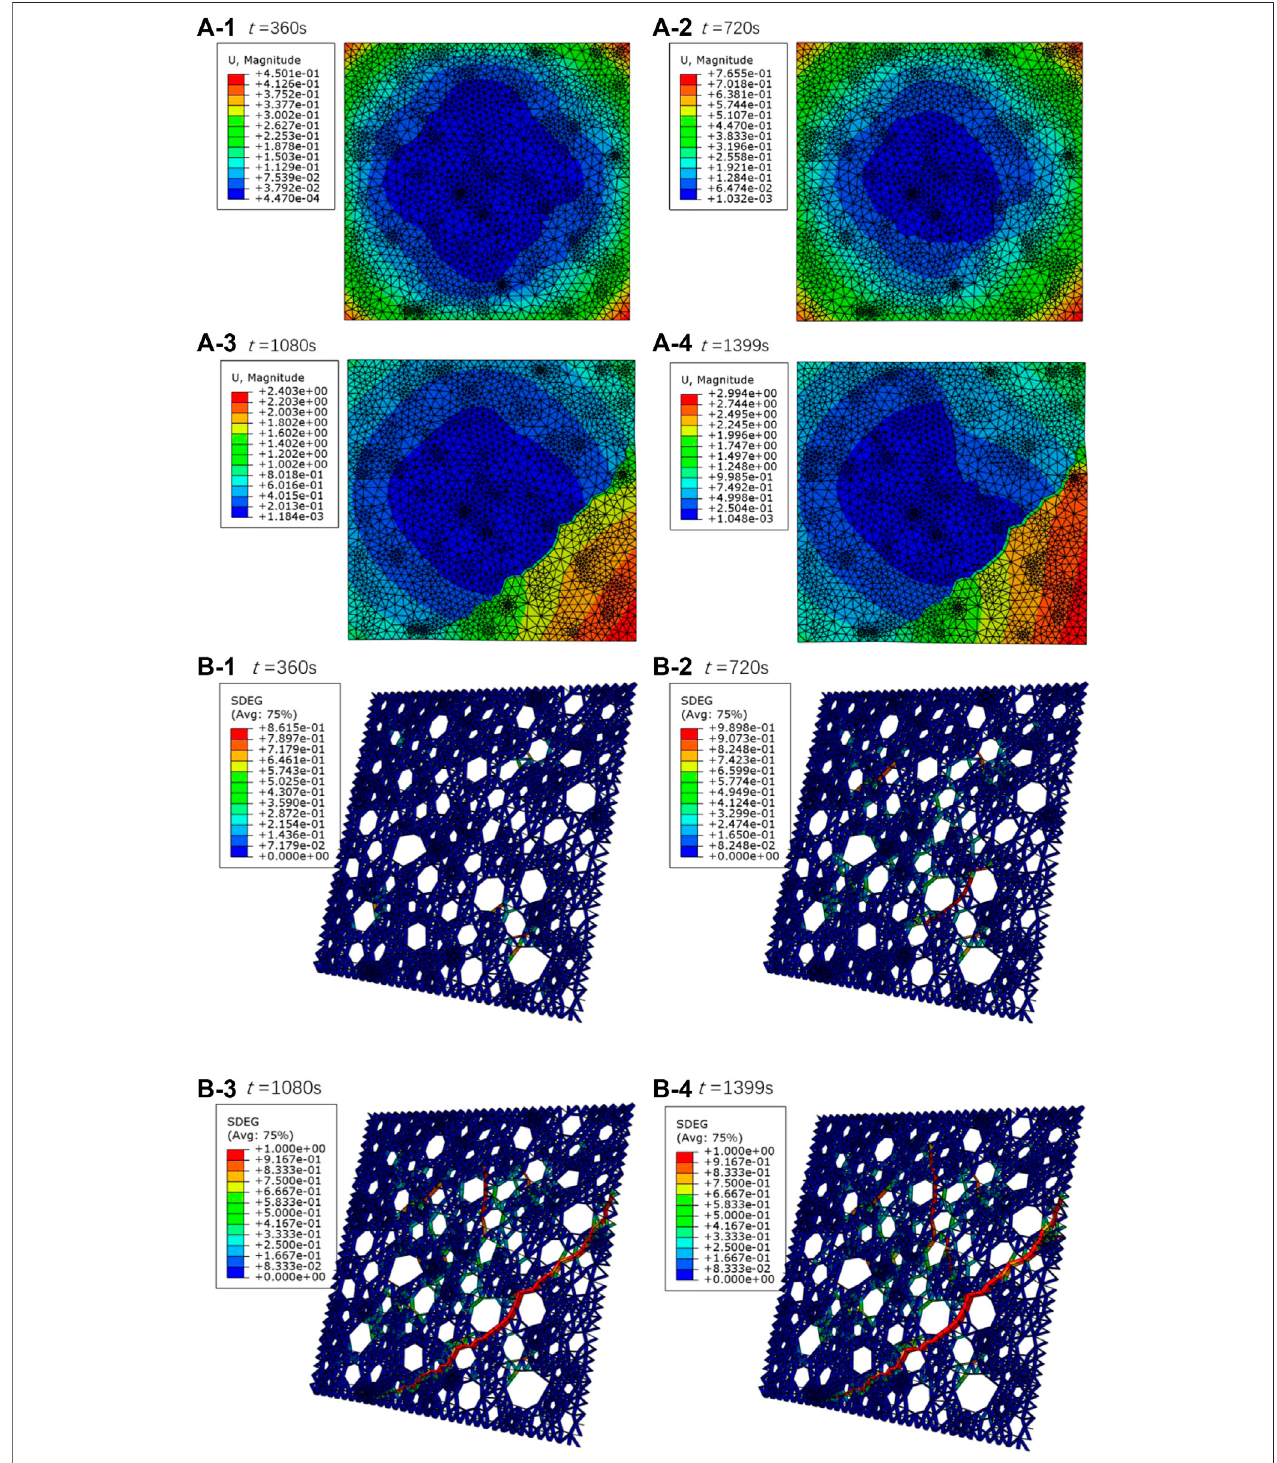
FIGURE 3 | (A) Numerical simulation results of thermal-induced deformation; (B) Numerical simulation results of thermal-induced damage in the cohesive elements.